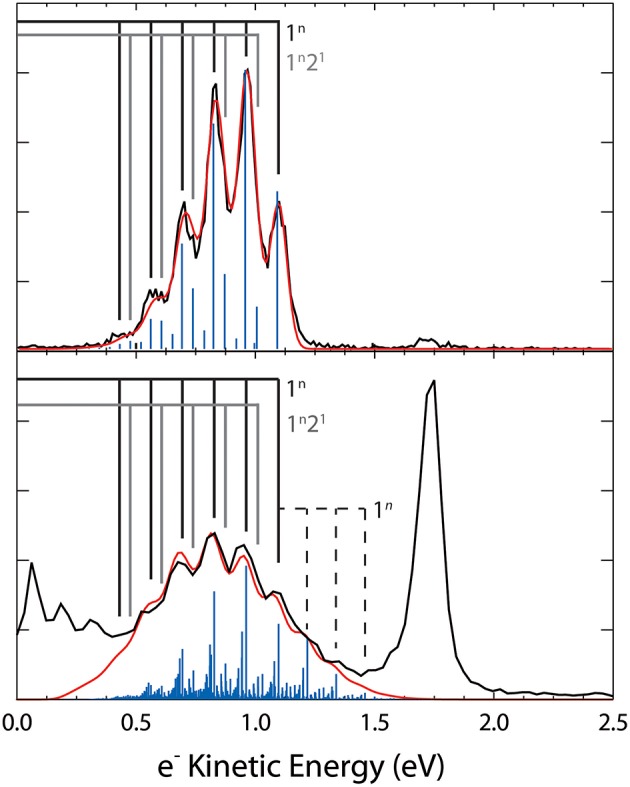
Top panel: Coldest O3- spectrum, shown in black (80 ms Trap H2/He buffer gas) with Franck-Condon simulation (blue trace) assuming a 0 K ion temperature. Bottom panel: hottest O3- spectrum, shown in black (500 μs, He buffer gas, high accel) with Franck-Condon simulations assuming v1 = 2,000 K and v2 = 1,500 K. The vibrational combs indicate the dominant transitions with the dashed comb indicating hot bands. Both simulations were Gaussian convoluted to generate the simulated spectra, shown in red.